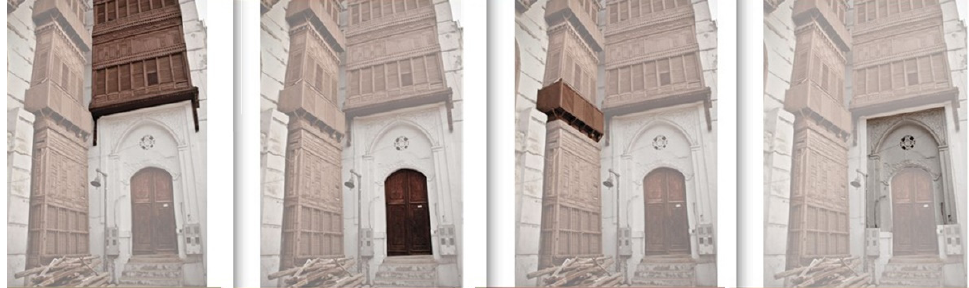
Figure 2. Common architectural elements of Jeddah historic buildings (highlighted); (left to right)—Roshan, gate, Manjur, and decorated plaster.